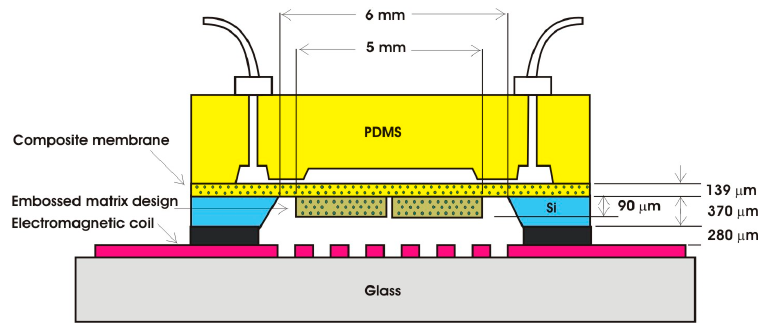
Figure 2. The design of the proposed EM micropump.